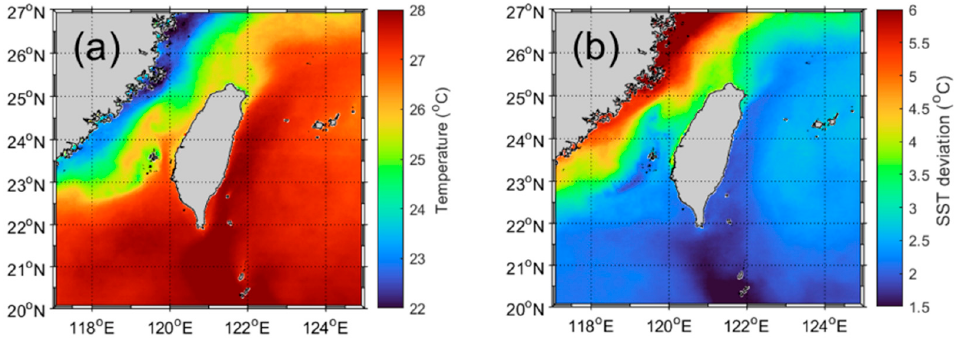
Figure 4. SST data in 2018 (unit: °C): ( a ) mean; ( b ) deviation.